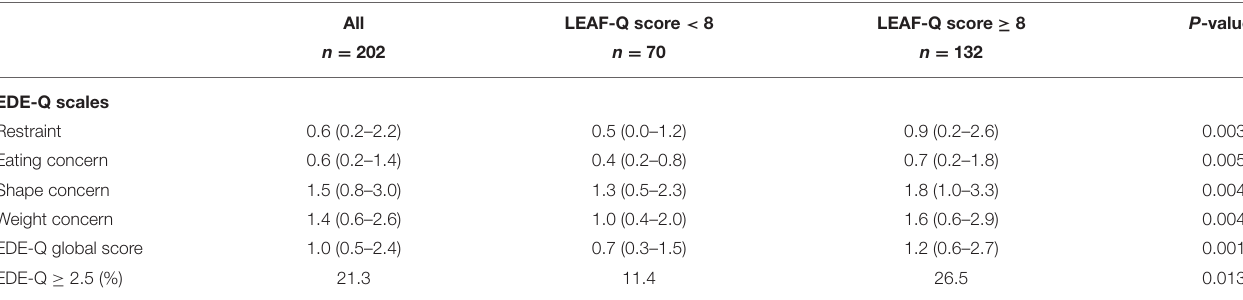
TABLE 2 | Symptoms of disordered eating behavior characterized by energy availability status.